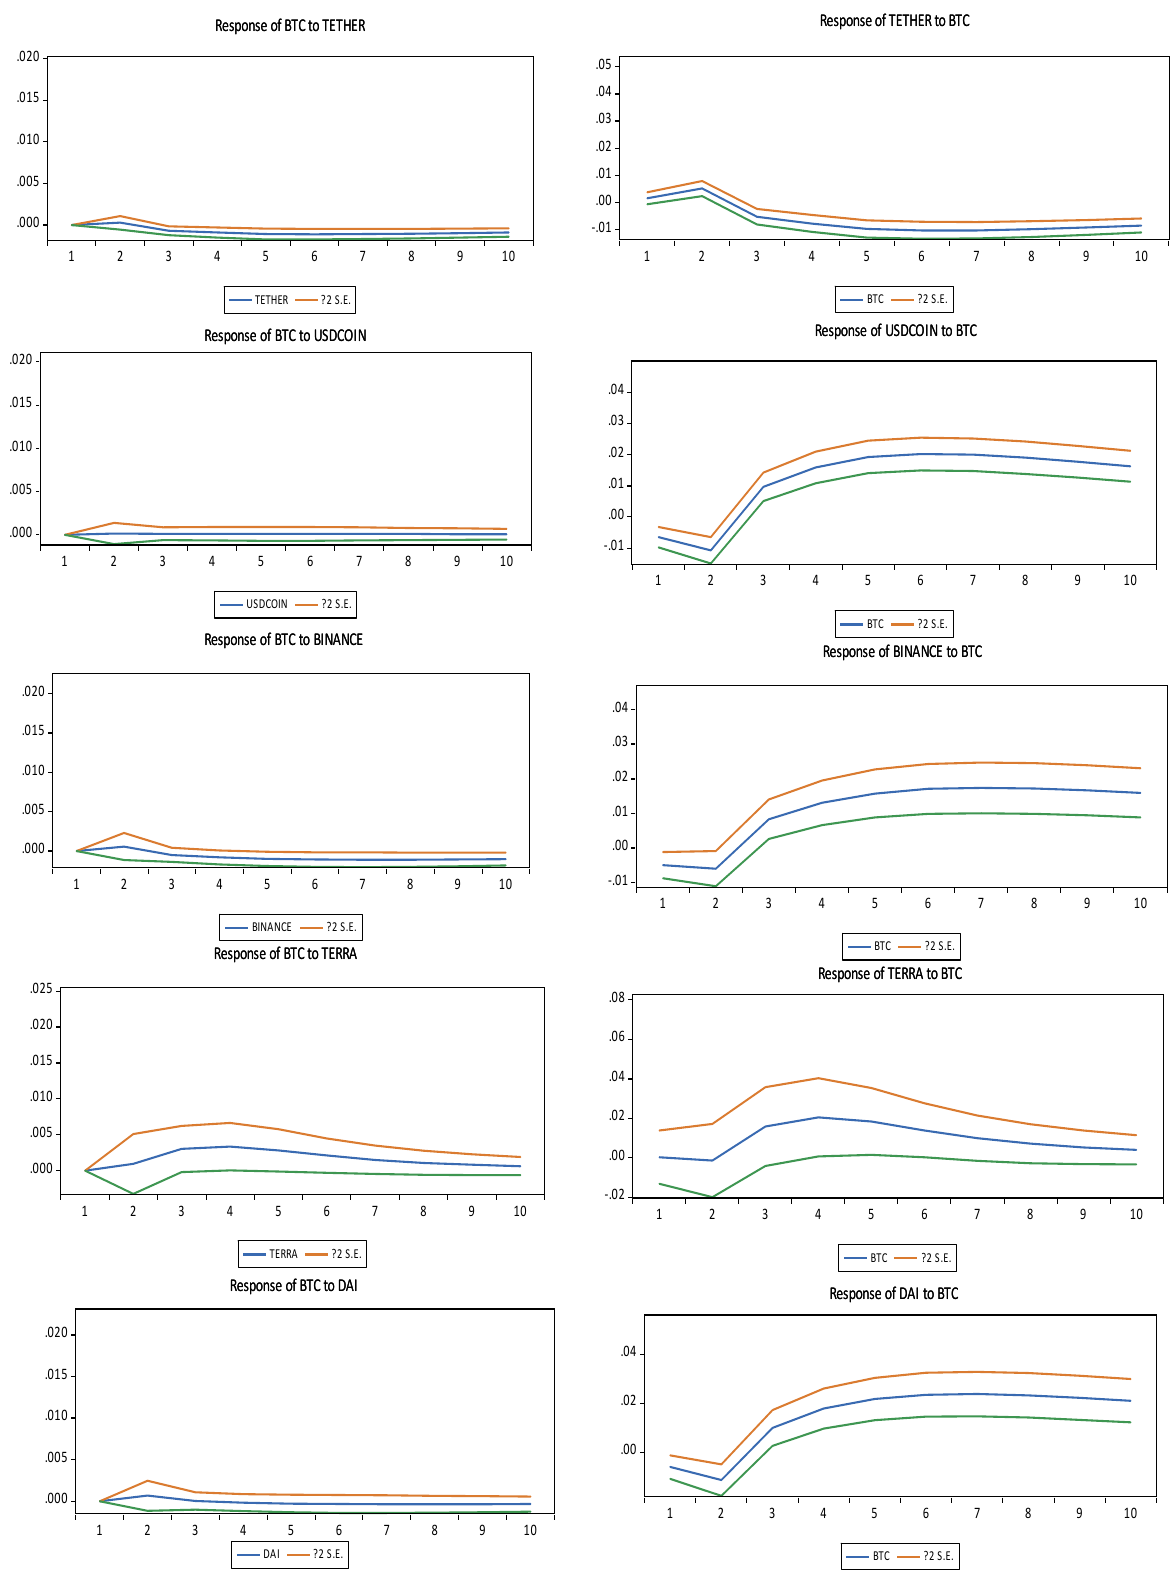
Figure 6. VAR impulse responses of the Bitcoin to stablecoins by subperiod 1 (pre-13 March 2021).